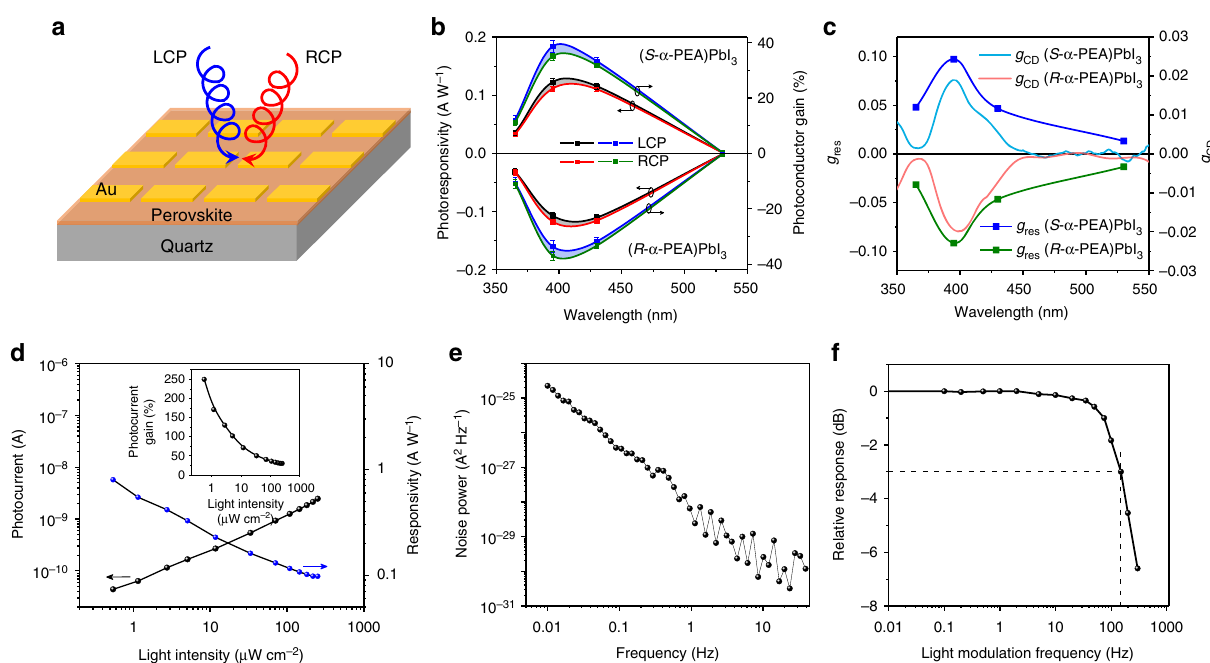
Fig. 3 The device performance of ( R - and S - α -PEA)PbI 3 fi lm photodetector. a Schematic diagram of our photodetector. b The responsivity and photoconductor gain of ( R - and S - α -PEA)PbI 3 device under LCP and RCP light at the wavelengths of 365, 395, 430, and 530 nm. The gray and cambridge blue area denotes the difference of responsivities and photoconductor gain under LCP and RCP irradiation, respectively, with identical intensity. c The wavelength dependent g res spectra. The g CD spectra are also shown here in order to facilitate comparison. d Light intensity dependent LDR and responsivity at 20 V under 395 nm irradiance. The inset is the light intensity dependent photoconductor gain. e Measured current noise at various frequencies. f Normalized response of the photodetector versus the input signal frequency. The -3-dB point is speci fi ed with the dash lines